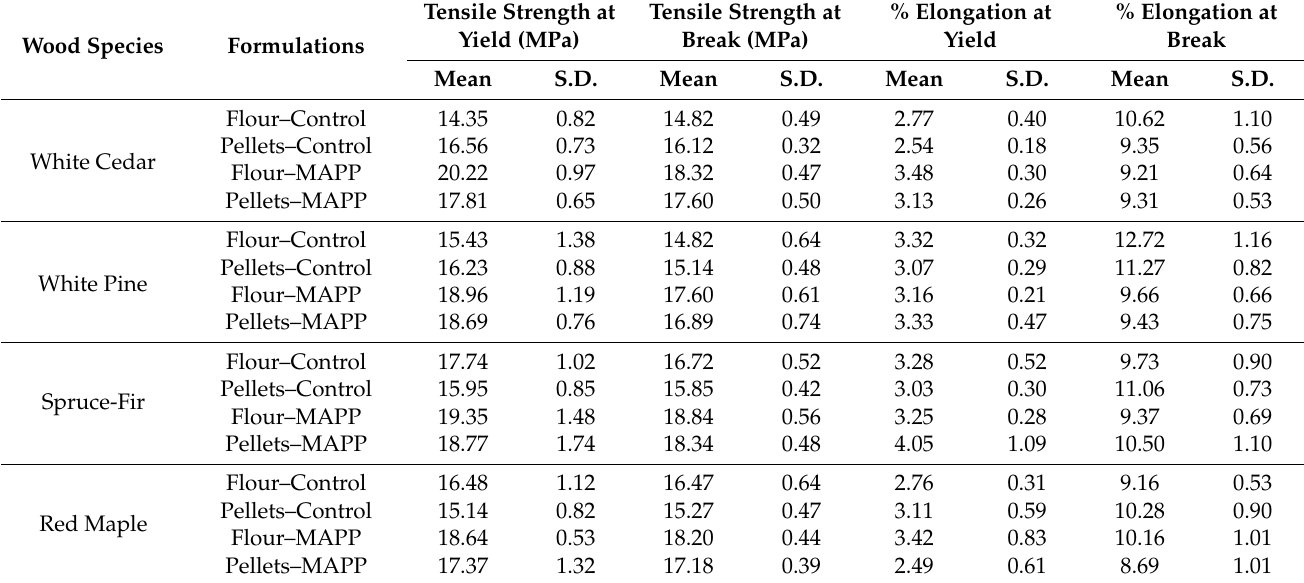
Table 3. Tensile strength and % elongation at yield and break for different formulations of WPCs.